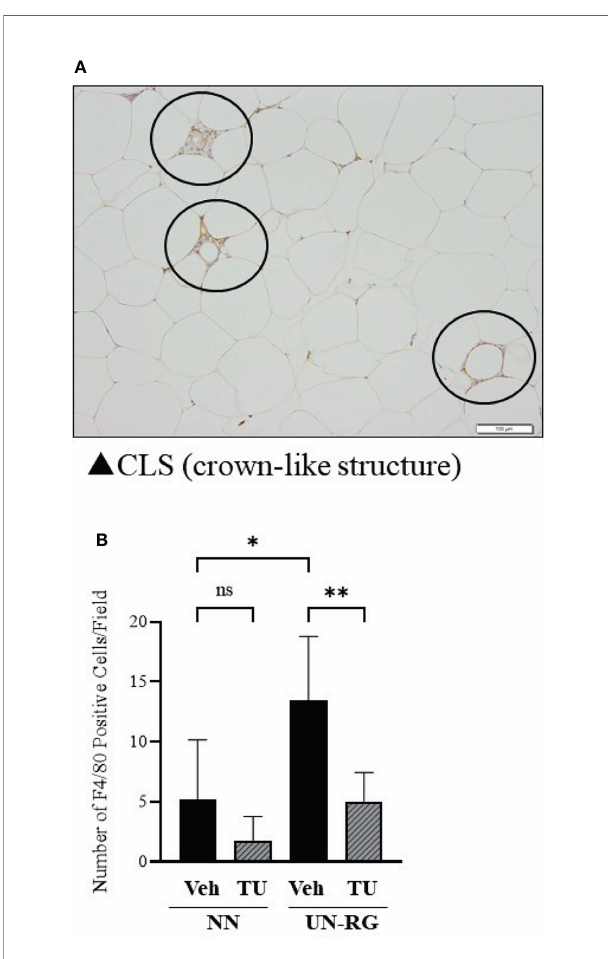
FIGURE 8 | Immunohistochemical detection of macrophages in epididymal adipose tissue. Circles indicate immunostaining for F4/80 in crown-like structures of epididymal adipose tissue from UN-RG-Veh pups at 16.5 wks of age (A) and the average number of F4/80-positive cells in the epididymal adipose tissue of NN-Veh, NN-TU, UN-RG-Veh, and UN-RG-TU pups (B) . The white bar indicates 100 m m. *P < 0.05, **P <